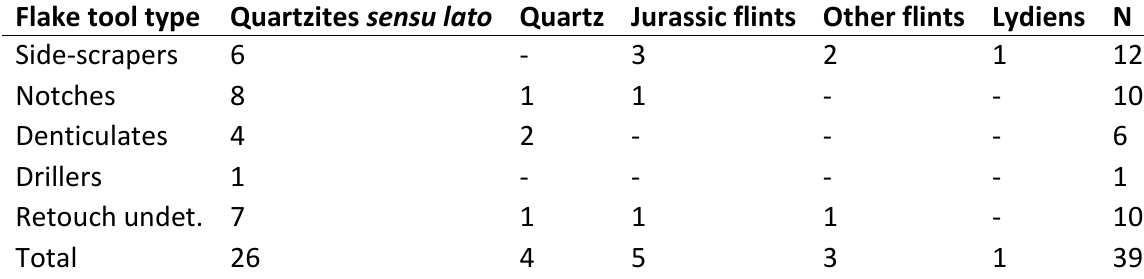
Table 10. Flake-tools identified at